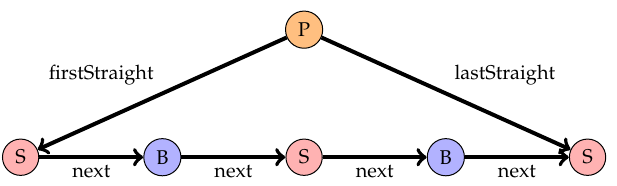
Figure 10. Exemplary graph of a PipePath consisting of Straight s and Bend